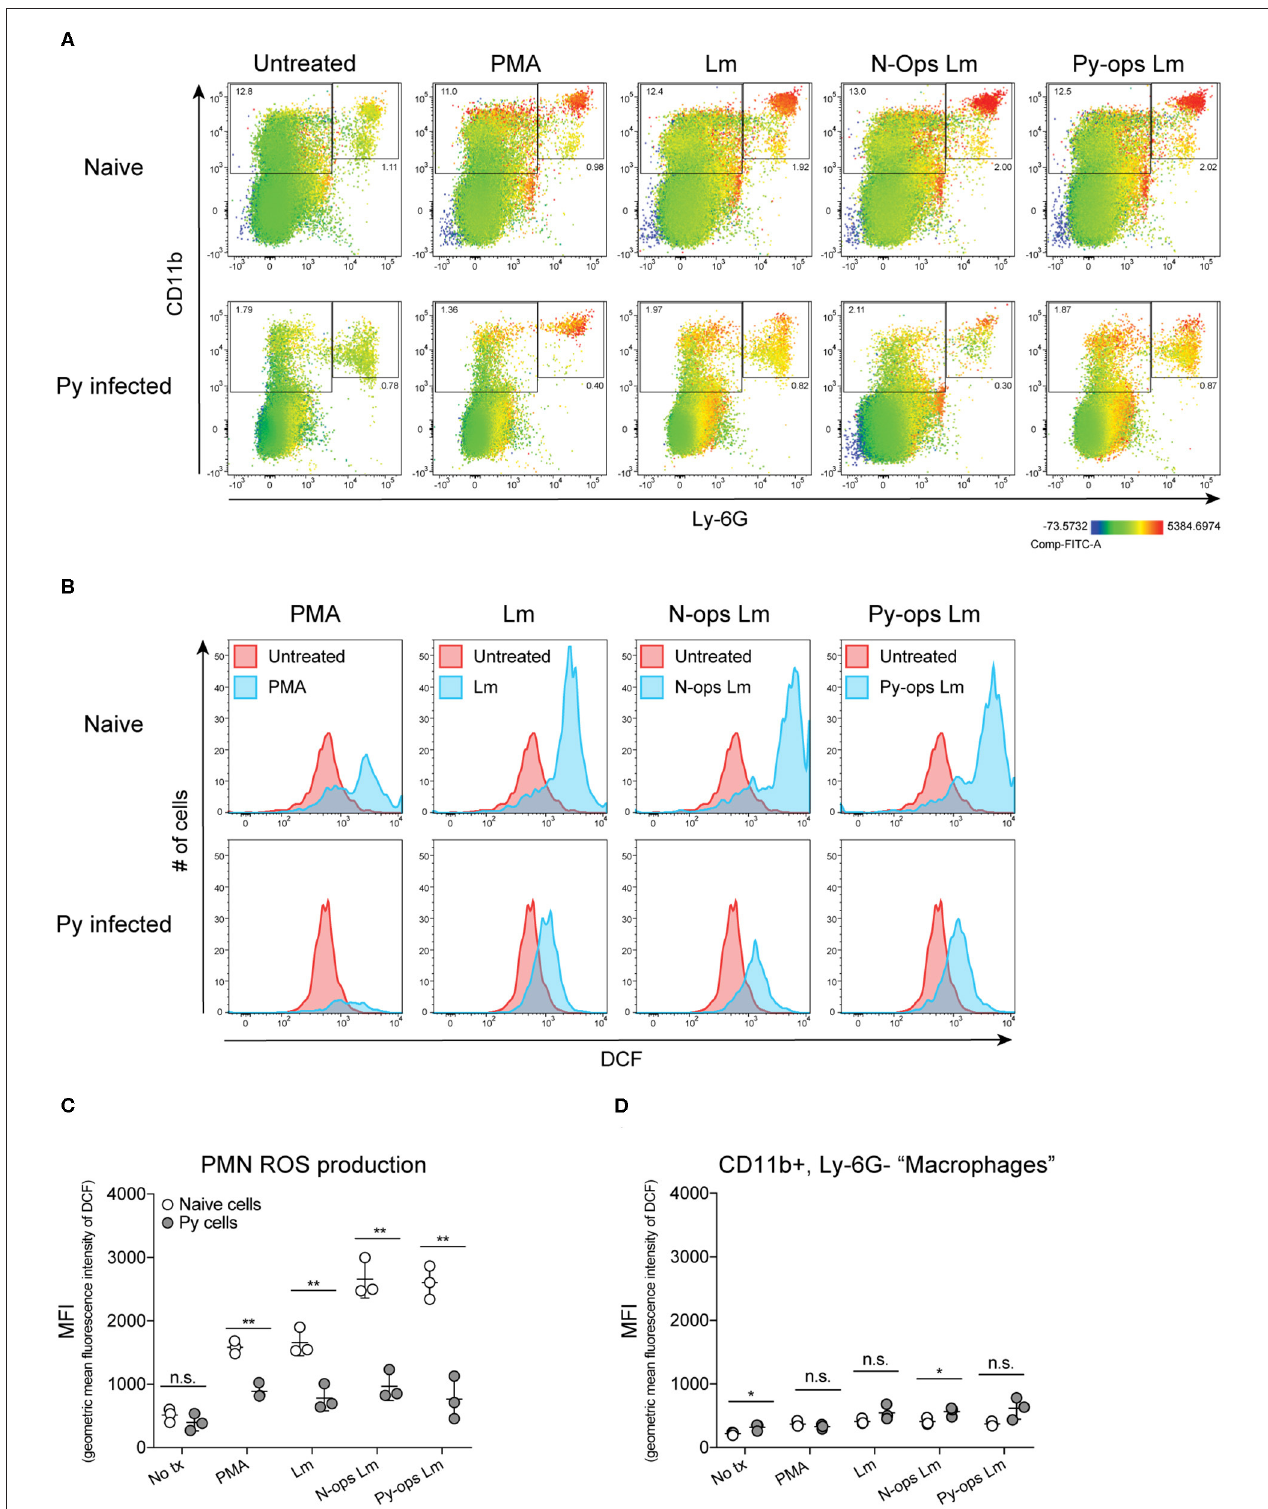
FIGURE 5 | Splenic PMNs from P. yoelii infected mice have defective ROS production in response to Lm. C57BL/6N mice were infected with 10 5 Py pRBCs. Single cell suspensions from whole spleens of naïve and Py-infected mice (days 14 or 15 p.i.) were incubated with DFC to detect intracellular ROS. Cells were then treated